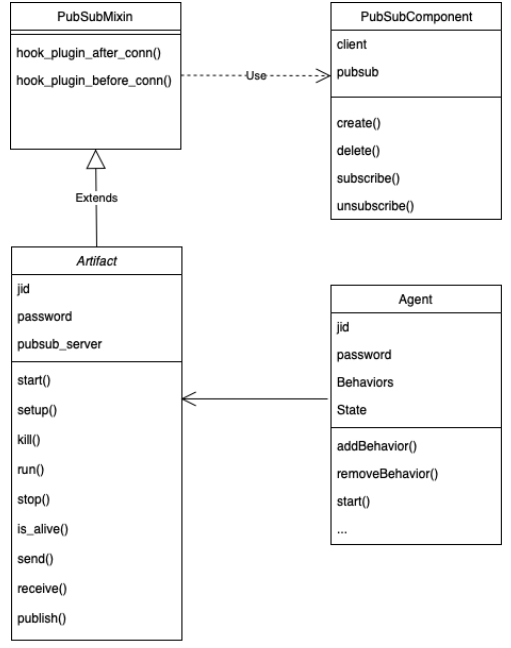
Figure 7. Class diagram of an IoT artifact in